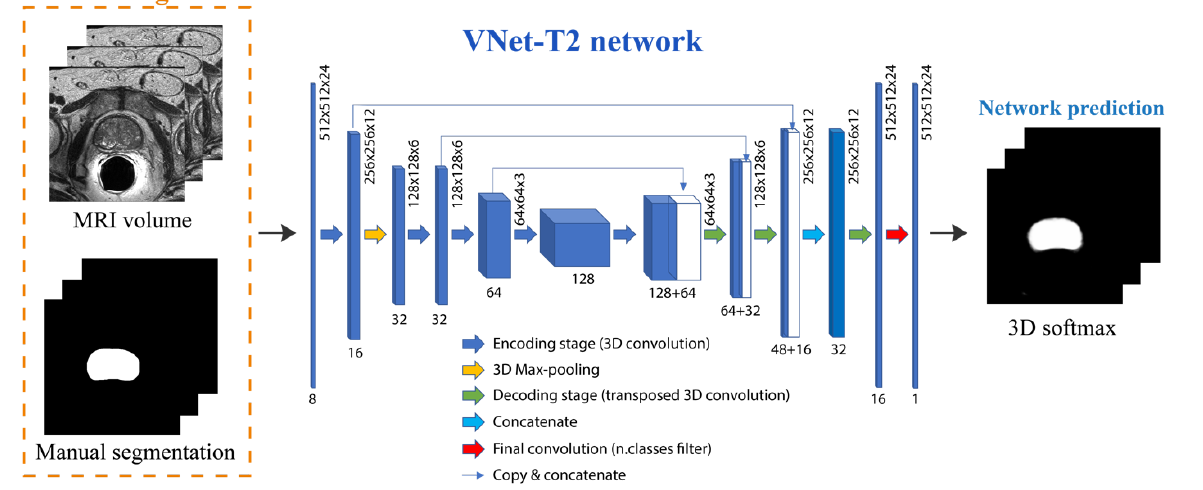
Figure 3. Architecture of the deep network employed in this work. Starting from the 3D MRI volume, the VNet-T2 network performs a volumetric segmentation of the prostate gland.